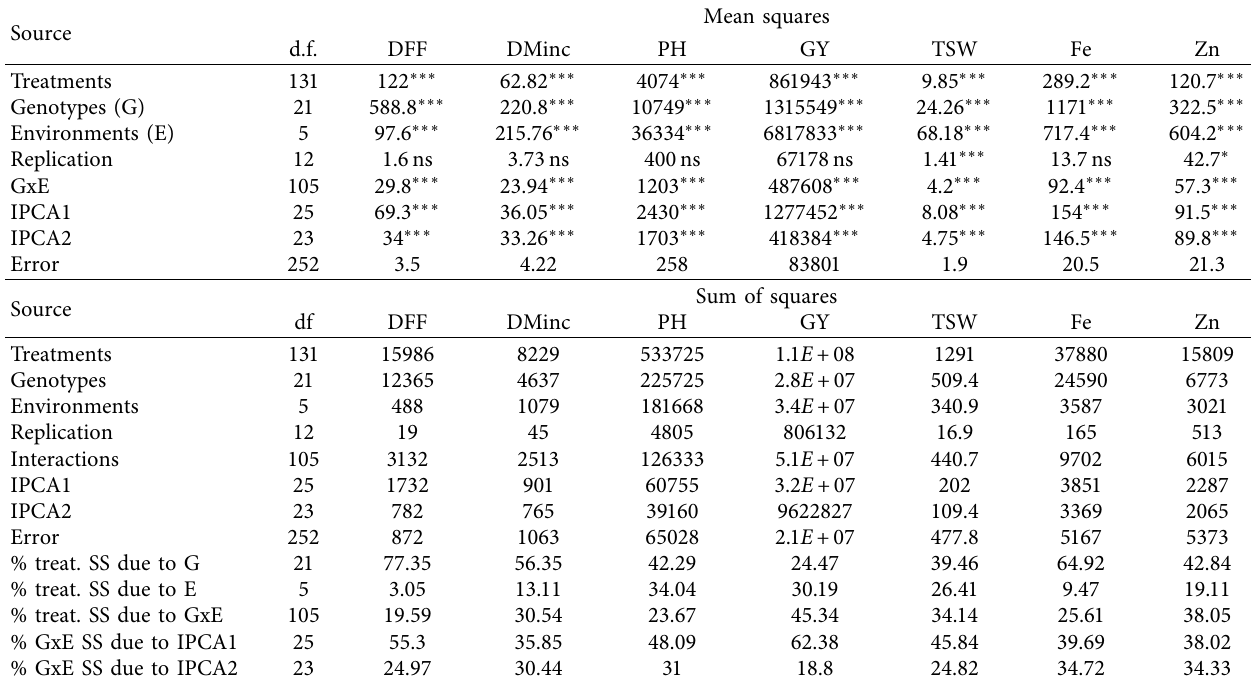
Table 7: Combined AMMI analysis of variance for 22 pearl millet OPV genotypes evaluated for growth and yield related traits in two locations over three seasons in Northern Ghana.